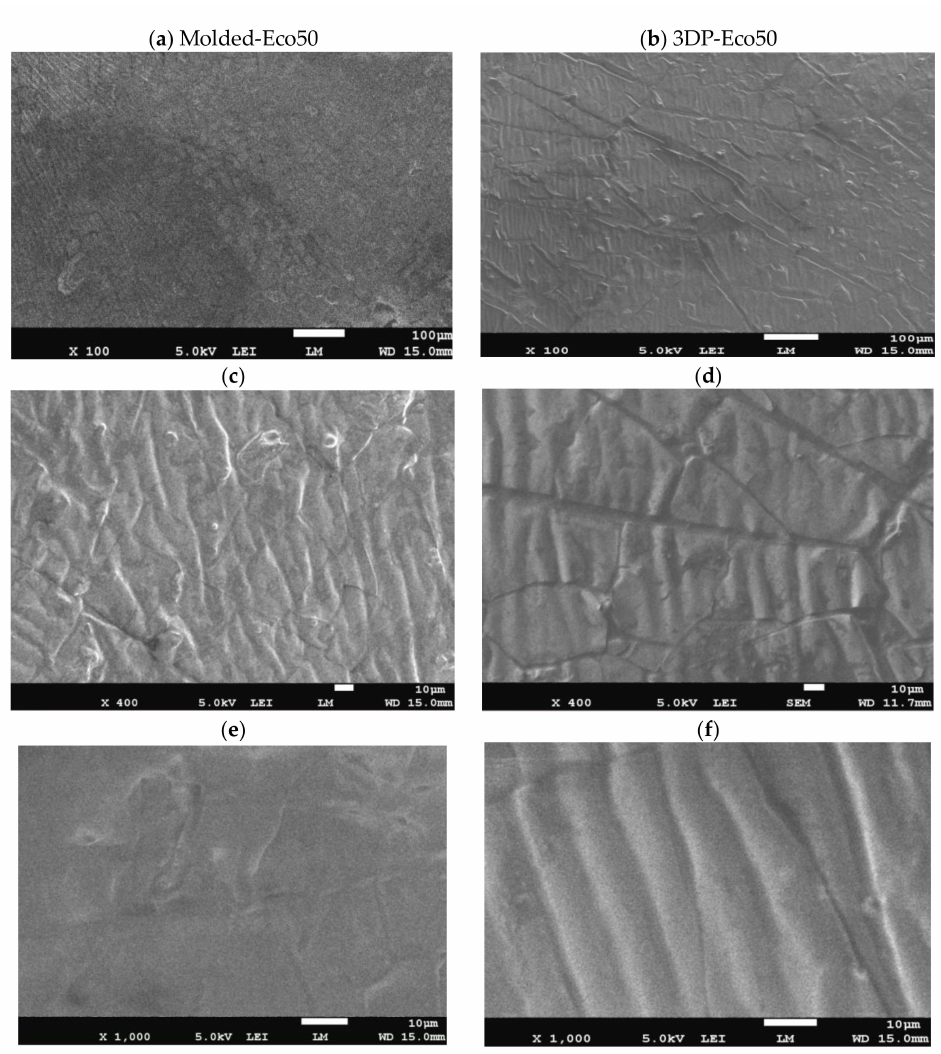
Figure 6. Representative scanning electron microscope (SEM) pictures (magnification 100 × , 400 × and 1000 × ) showing the di ff erent surface patterns of ( a , c , e ) molded silicone and ( b , d , f ) 3D-printed silicone.